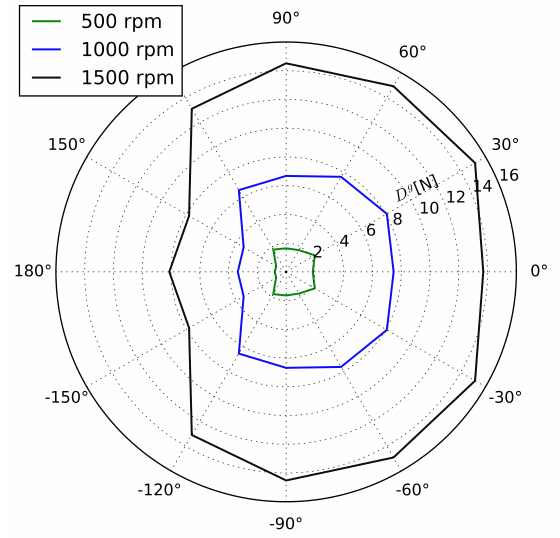
) [N], adapted from i